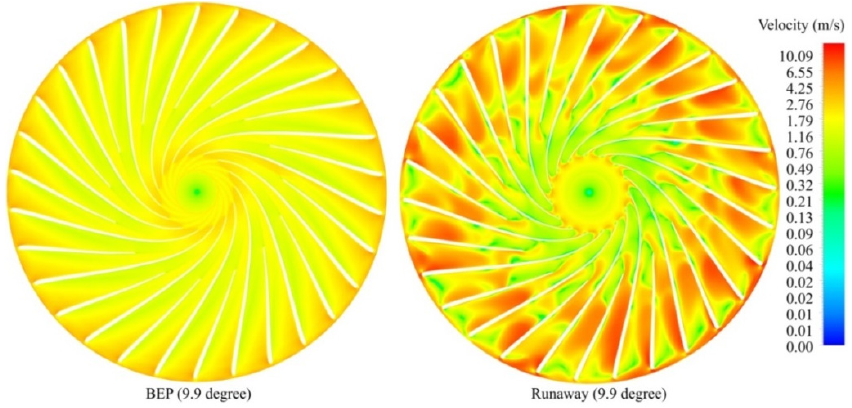
Figure 14. Contours of the velocity distribution near the surface of the runner crown at BEP and runaway ( α = 9.9 ˝ ) operating conditions; the contours are in a rotating frame of reference, and a logarithmic scale is shown.